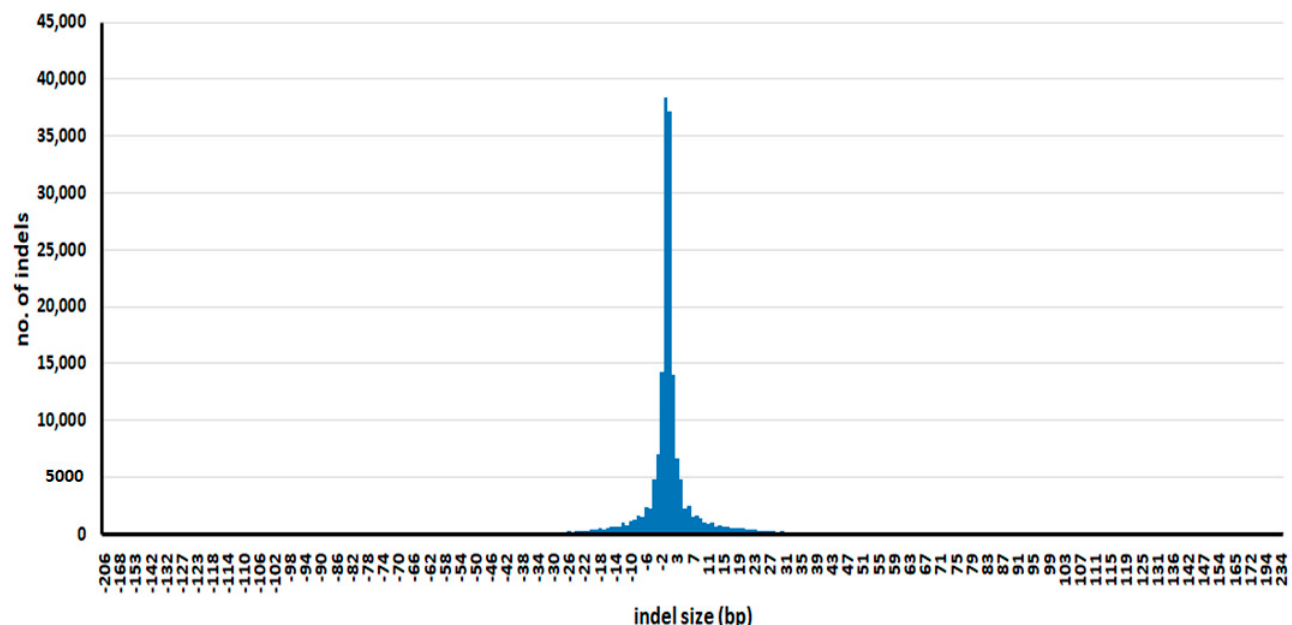
Figure 2. Distribution of InDel sizes. Minus values are deletions, and positive values are insertions.